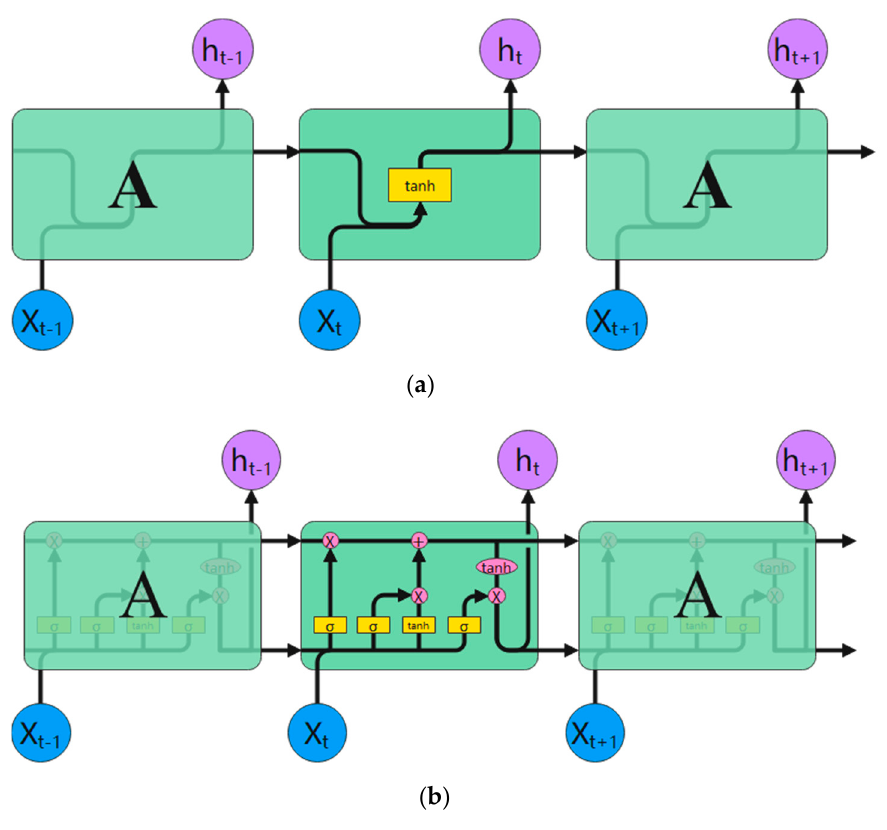
Figure 5. Structural units of RNN and LSTM. ( a ) Structural unit of RNN. ( b ) Structural unit of LSTM.